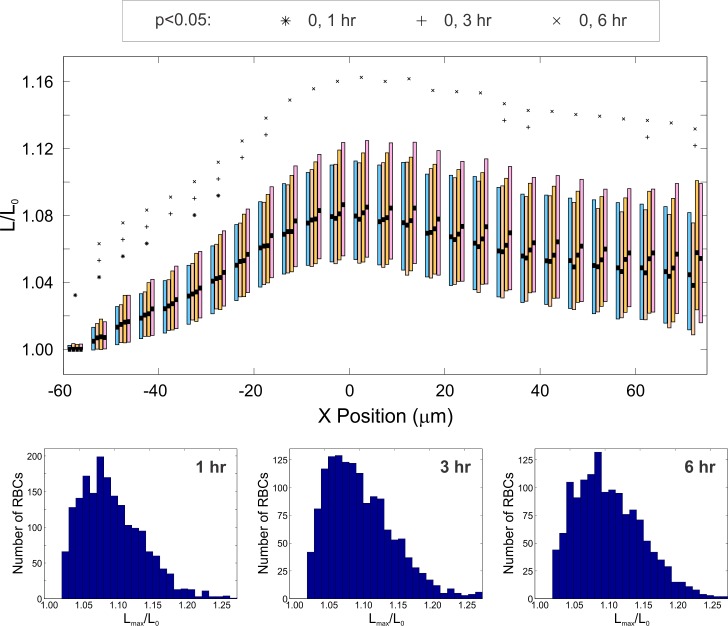
Effect of time elapsed post-prandial on stretching dynamics of OMA+ RBCS.(A) Box plots of instantaneous stretching ratio as a function of X position in the channel for blood draws taken postprandially in participants with OMA. The top and bottom of the rectangles represent the 25th and 75th quartiles, the thick black bars indicate the median, and the dark square markers indicate the mean. Shown in the second row are histograms for Lmax/L0. The total number of cells observed: n0HR = 1955, n1HR = 1870, n3HR = 1450, and n6HR = 1393